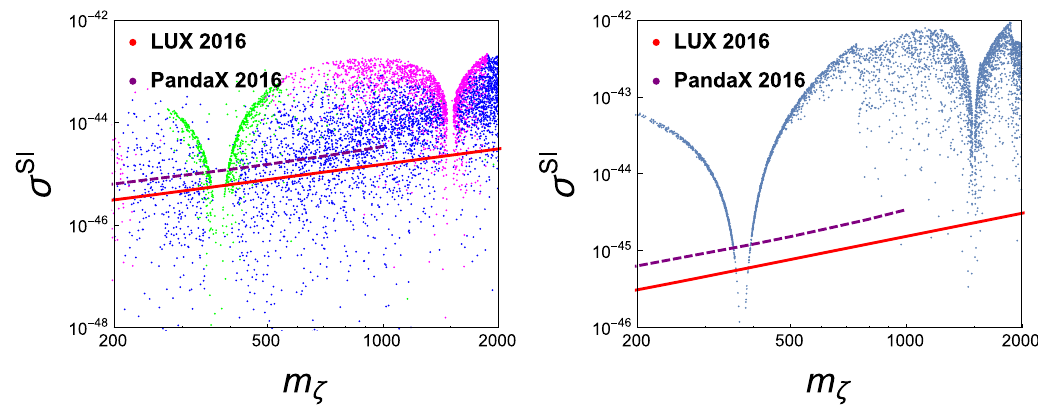
Figure 3 . (cid:27) SI as the function of m (cid:16) for the general (left panel) and simpli(cid:12)ed (right panel) cases respectively, where the simpli(cid:12)ed case means L;R are decoupled. All points in the plots give the relic density within the 3 (cid:27) deviation from the observed central value. Constraints of oblique observables within 2 (cid:27) are also taken into